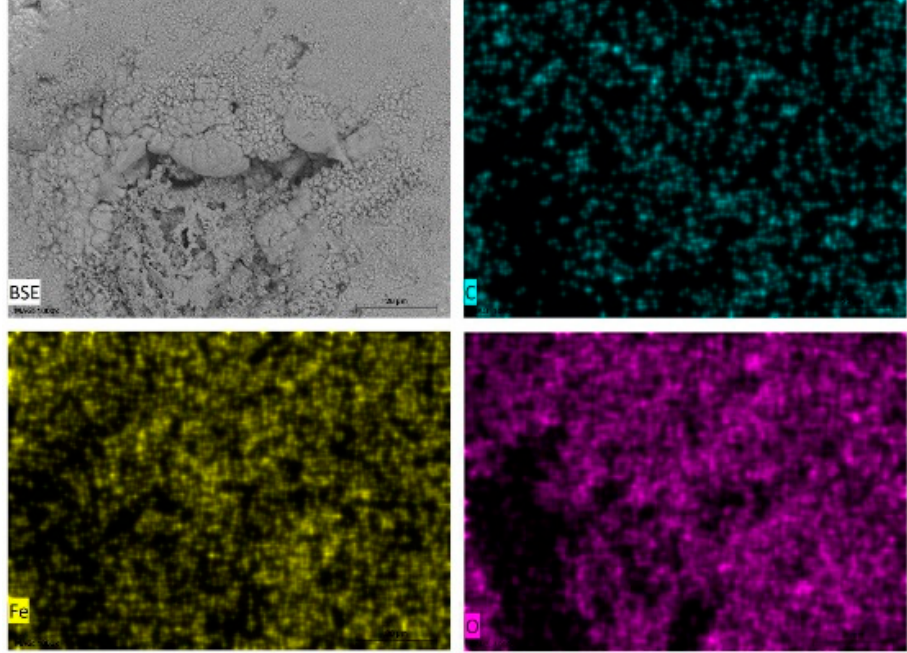
Figure 9. SEM/EDS mapping images of carbon steel sheet (CR1 ≈ EN 1.0338) surfaces after immer- sion in lemon juice (pH = 2.22).